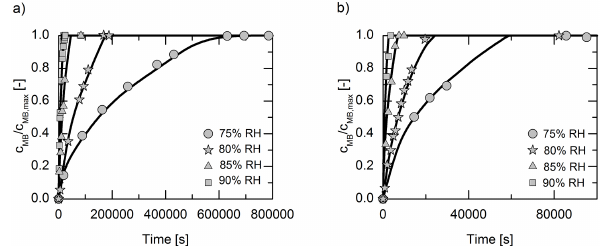
Figure 10. MB concentration profiles in PVA films of 170µm thickness as a function of RH at 298.15K (a) and at 313.15K (b) . Symbols are experimental data and lines are modeled profiles using oxygen diffusion coefficients in the PVA film from Table 2.